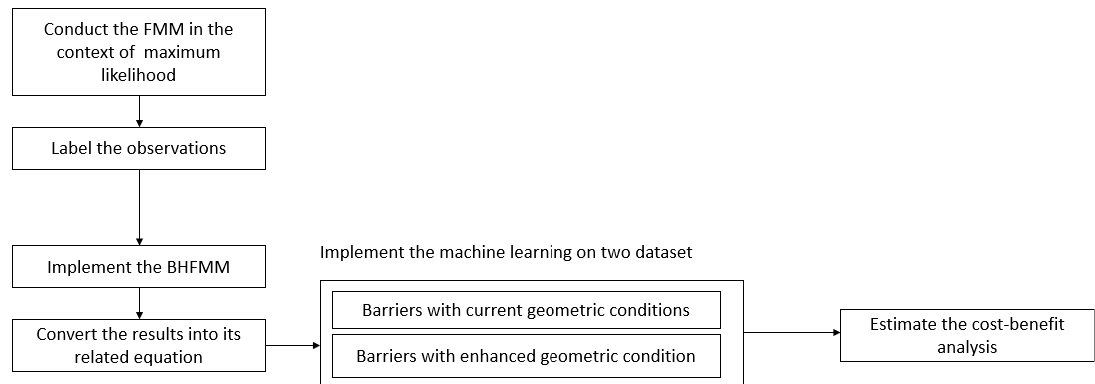
Figure 1. Methodological research approach.